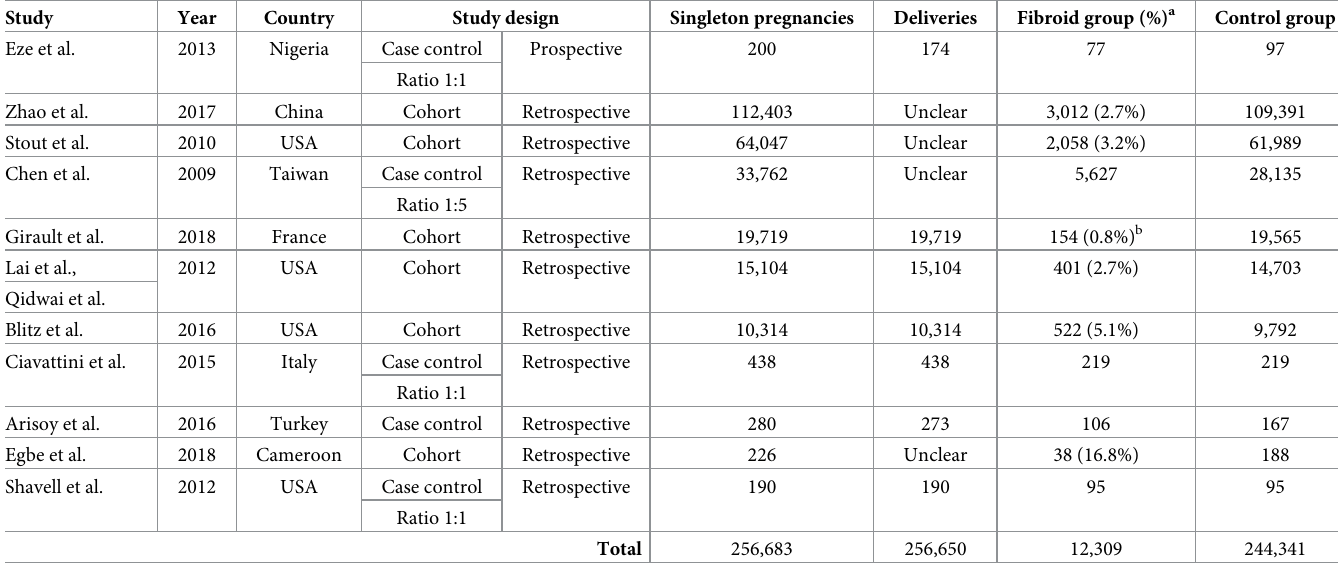
Table 1. Study characteristics and sample